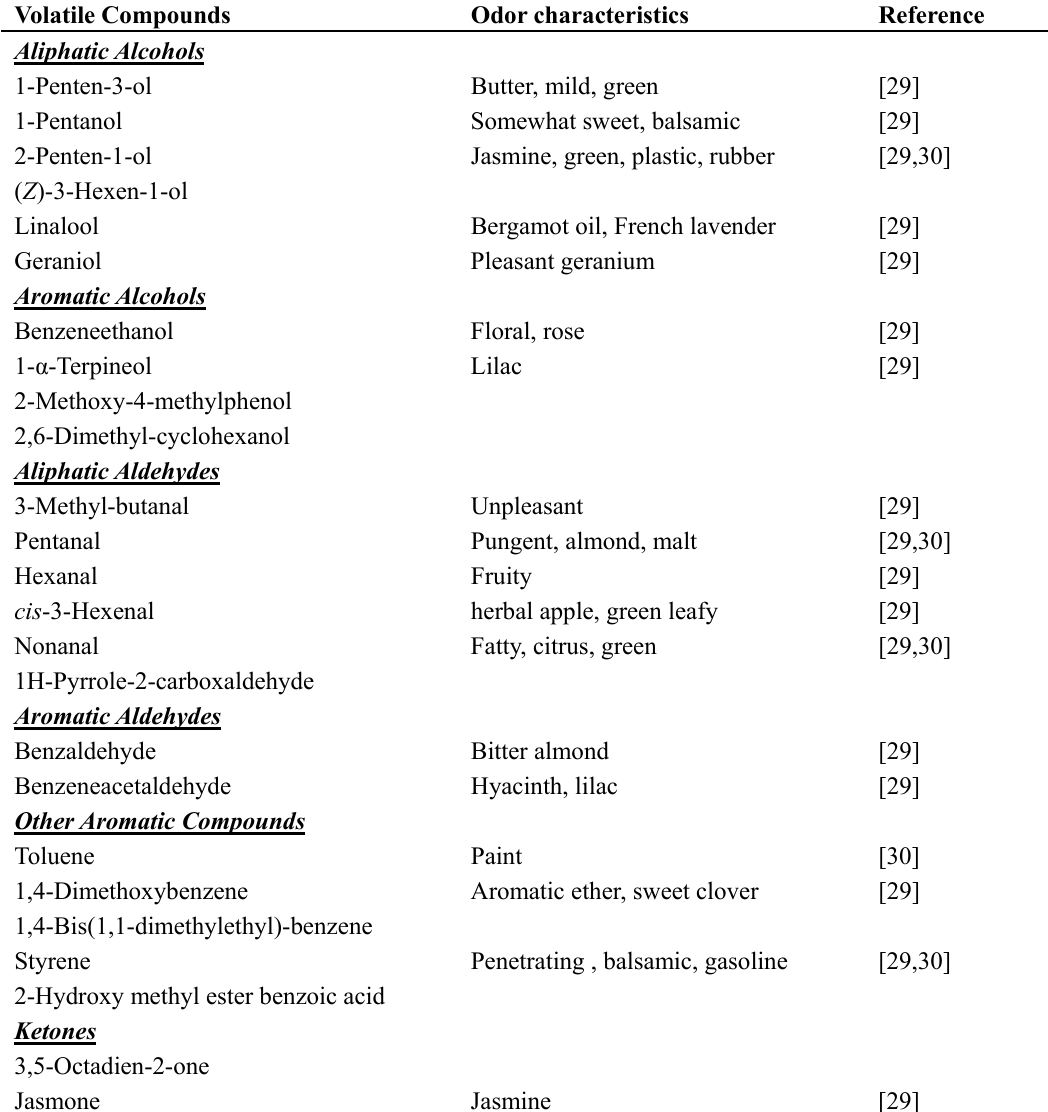
Table 1. 39 volatile compounds identified in 24 green tea samples and their odor characteristics reported as the